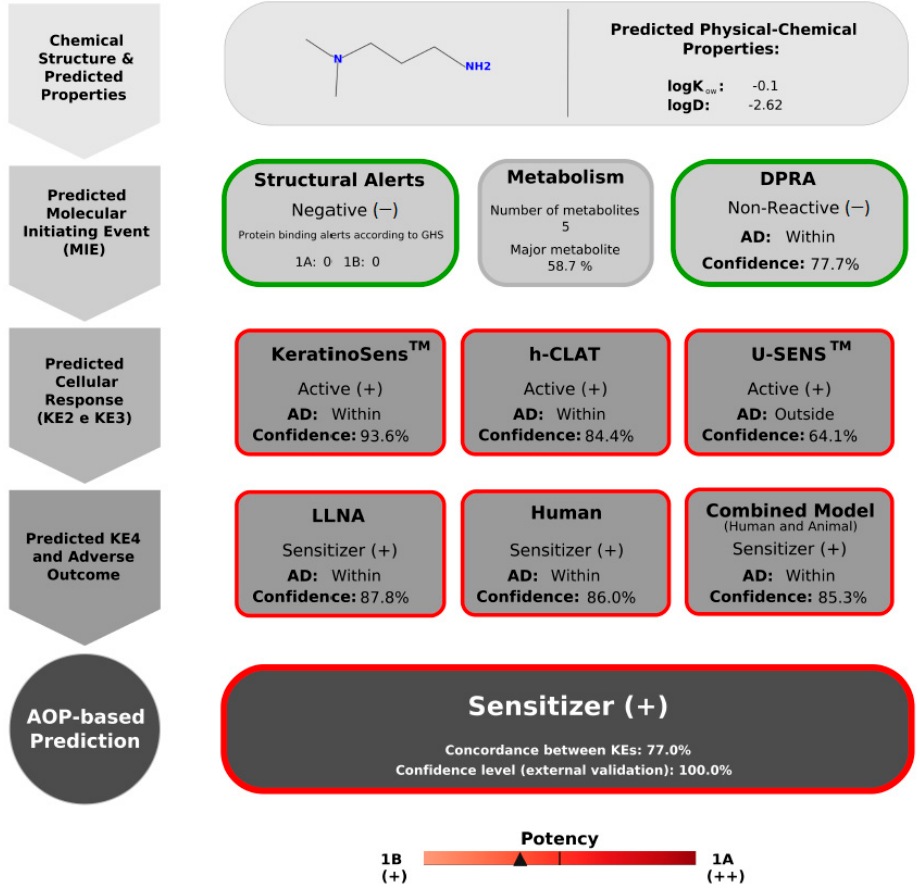
Figure 4. Example of an AOP-based in silico result generated by the AOP-Sens for the chemical 3-Dimethylamino propylamine (positive results are presented in red and negative results are presented in